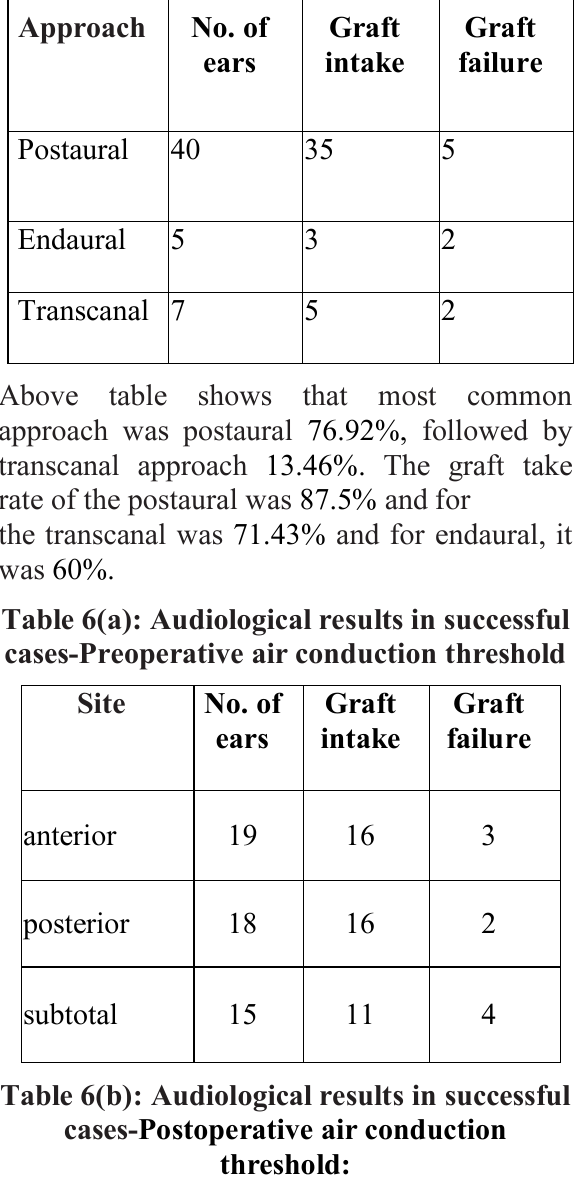
The graft take rate in case of posterior and anterior perforation were 88.89% and 84.21% respectively which was significantly more than that of subtotal perforation 73.33%.